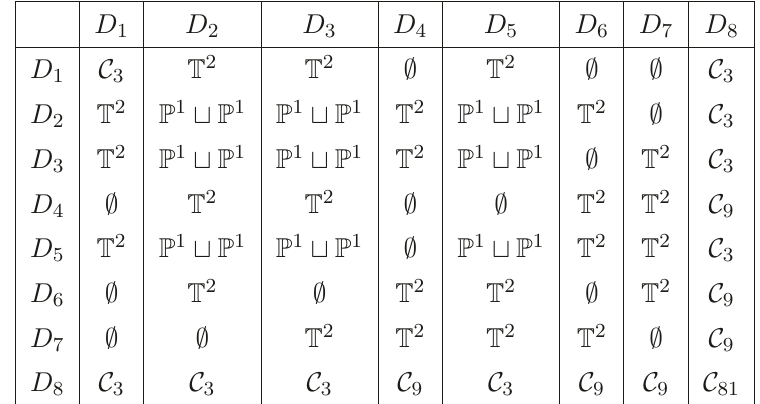
denotes a curve with Hodge C g